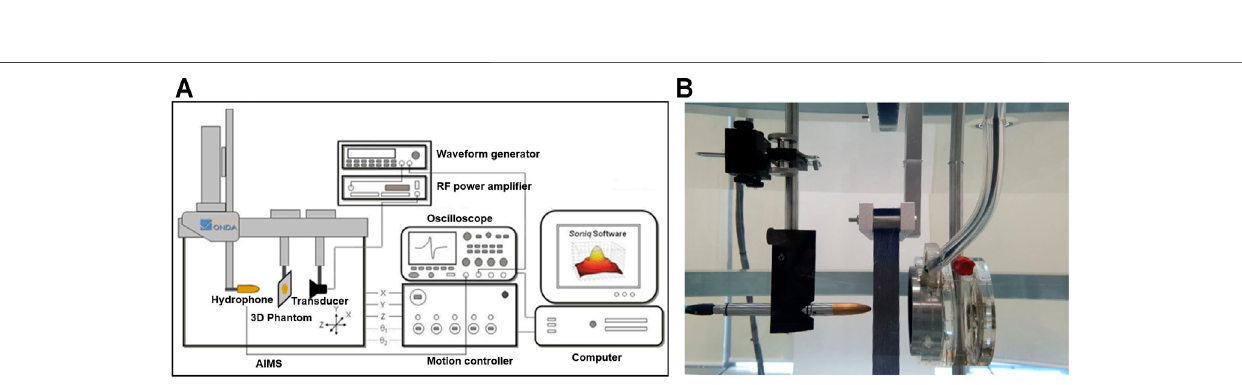
FIGURE 2 | (A) The Acoustic Intensity Measurement System (AIMS) is a hydrophone scanning system that enhances acoustic measurement productivity to map acoustic fi elds in degassed water. (B) Measurement of acoustic pressure in the water tank of AIMS.